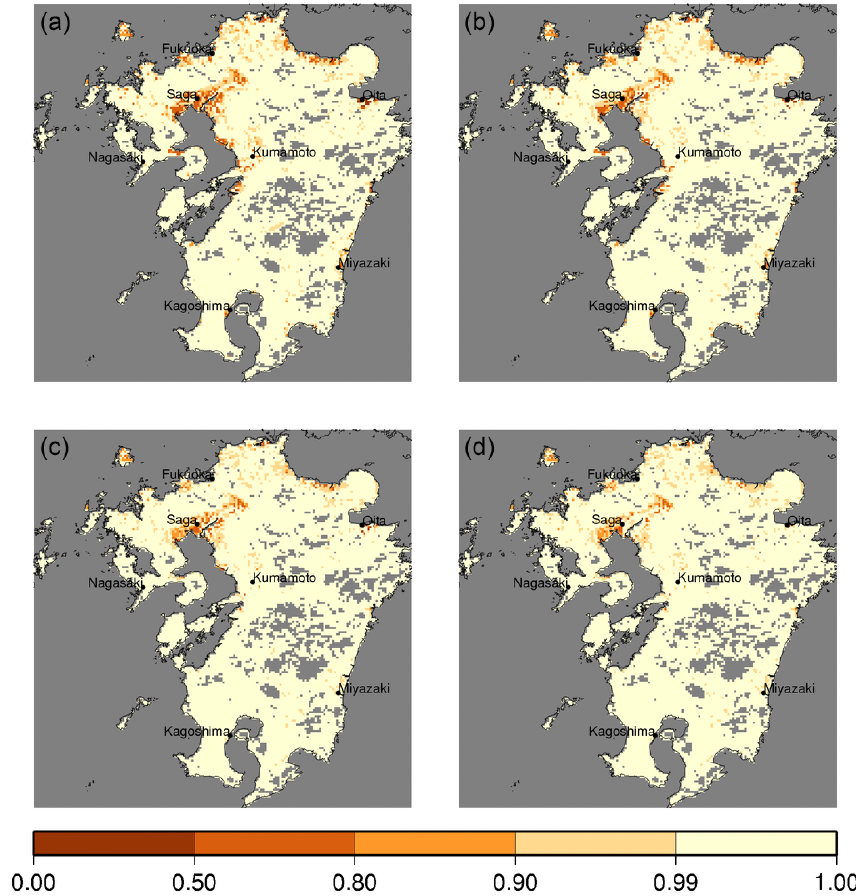
Figure 8. Water sustainability index. (a) LOC-I1 (localized model with implicit aqueducts transferring water to one adjacent grid cell), (b) LOC-I5 (localized model with implicit aqueducts transferring water to a maximum of five surrounding grid cells), (c) LOC-I5O (localized model with implicit aqueducts transferring water to a maximum of five grid cells, including cells outside the basin), and (d) LOC-I5OE (localized model with implicit aqueducts transferring water to a maximum of five grid cells, including cells outside the basin as well as explicit aqueducts). Symbols show the centers of prefecture capital cities. For visibility, only the mean annual withdrawal > 0 . 03m 3 s − 1 is